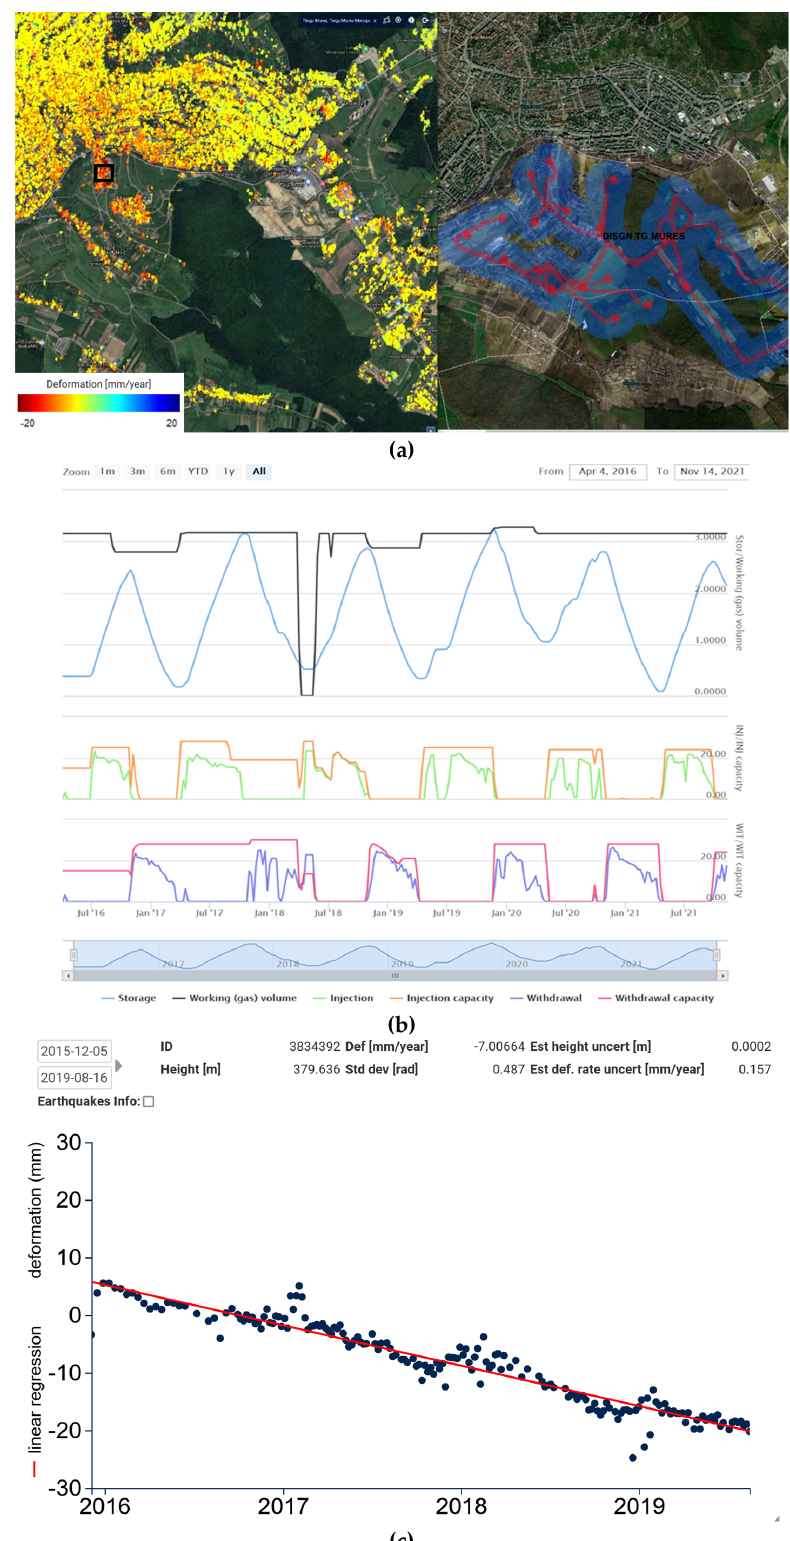
Figure 17. Subsidence of underground gas storage area: ( a ) subsidence related to gas storage ( left ) and gas storage facilities ( right ; detail from [55]); ( b ) injection/extraction cycles (gas storage historical data from [56]); ( c ) subsidence cycles measured with